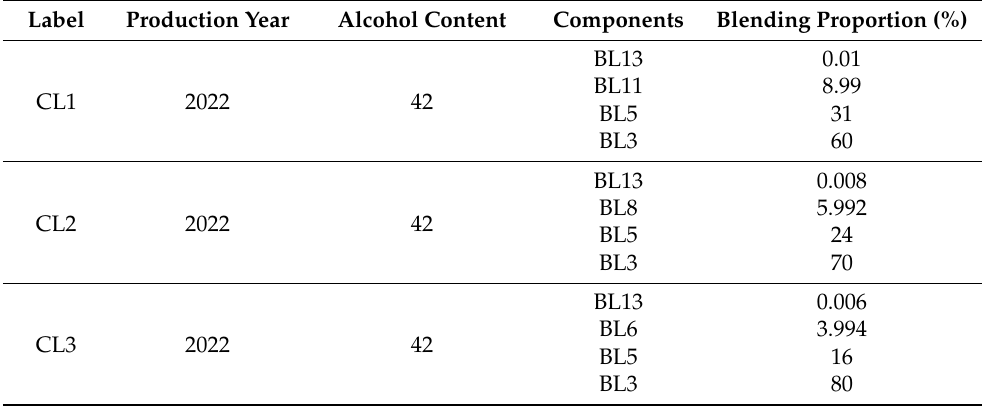
Table 2. Details of the commercial liquors.